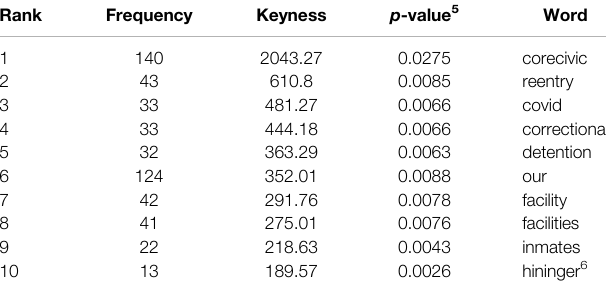
TABLE 2 | Keywords of the CoreCivic corpus in comparison to the oANC.